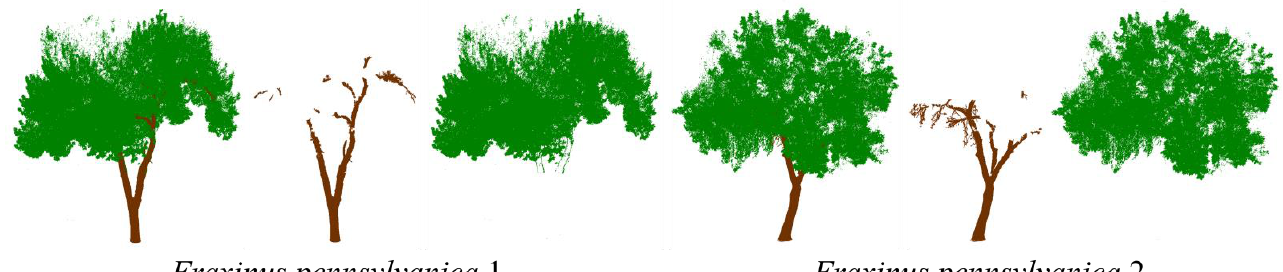
Figure 15. The wood–leaf classification results of two Fraxinus pennsylvanica trees. The wood–leaf classification result of each tree contains three sub-graphs (left: all tree points; middle: classified wood points; right: classified leaf points). Brown: wood points; green: leaf points. Table 6. The point statistics information of two Fraxinus pennsylvanica trees classification results.